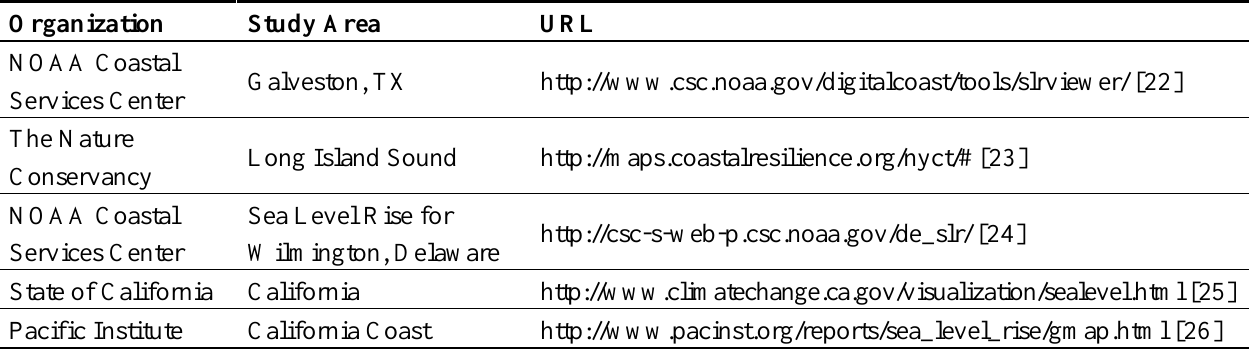
Table 1. Listing of sea level rise viewers included in the initial usability